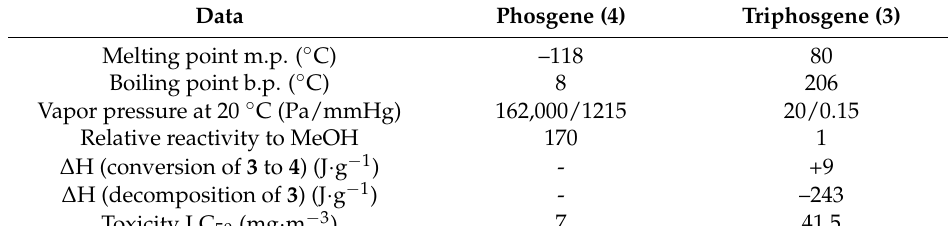
Table 3. Physical, chemical, thermochemical, and toxicity data of phosgene and triphosgene [28,29]. Data